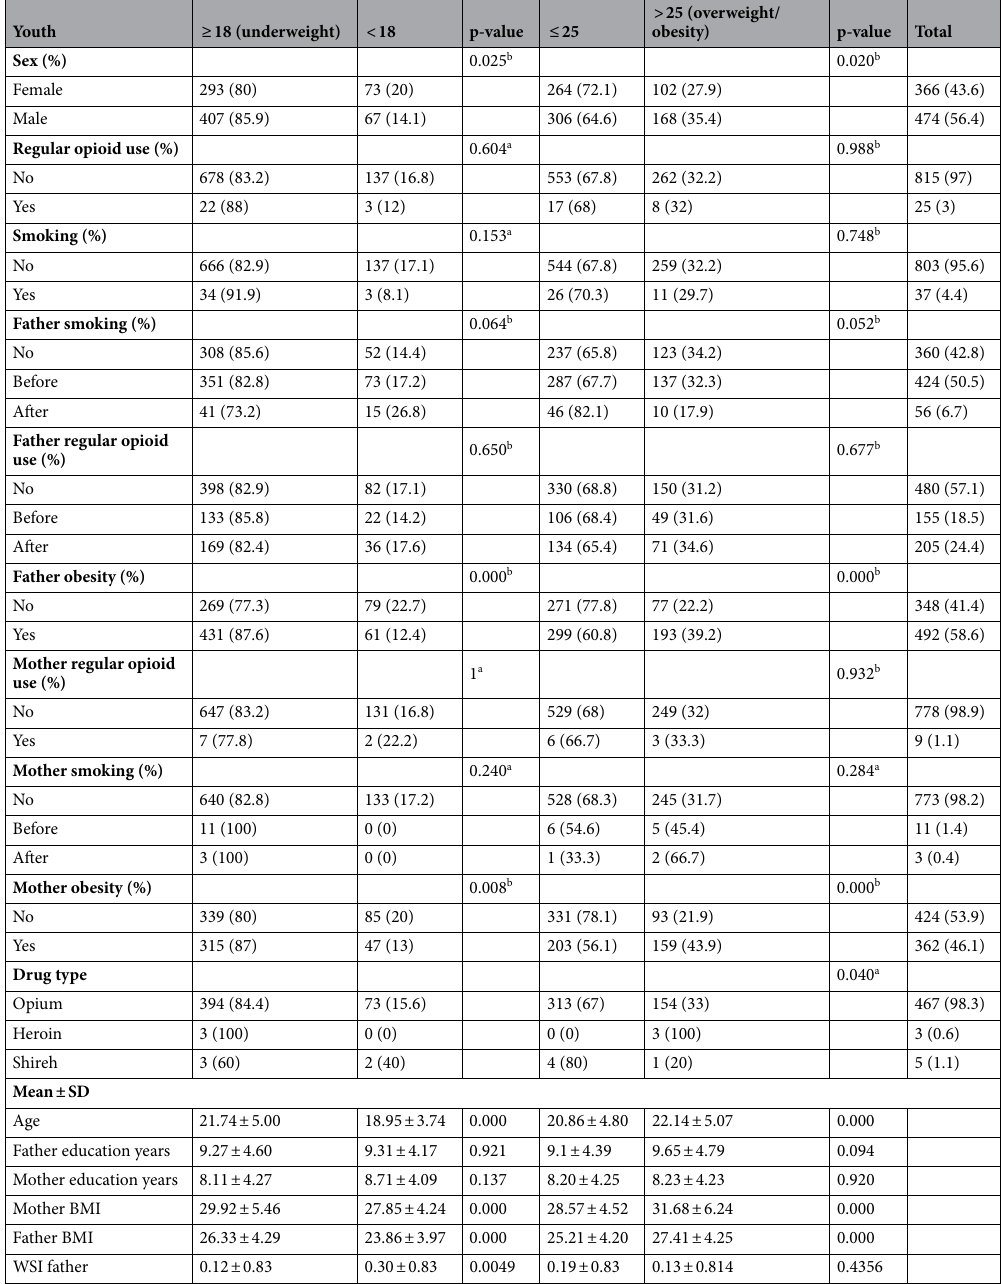
Table 1. Baseline characteristics of the study population categorized by BMI. Data are given as mean ± SD or absolute number n (percentage). p-values for differences between categories were obtained using the t-test for continuous variables and using the χ 2 or Fisher Exact Test for categorical variables. BMI: body mass index. a Fisher’s exact test. b Chi square